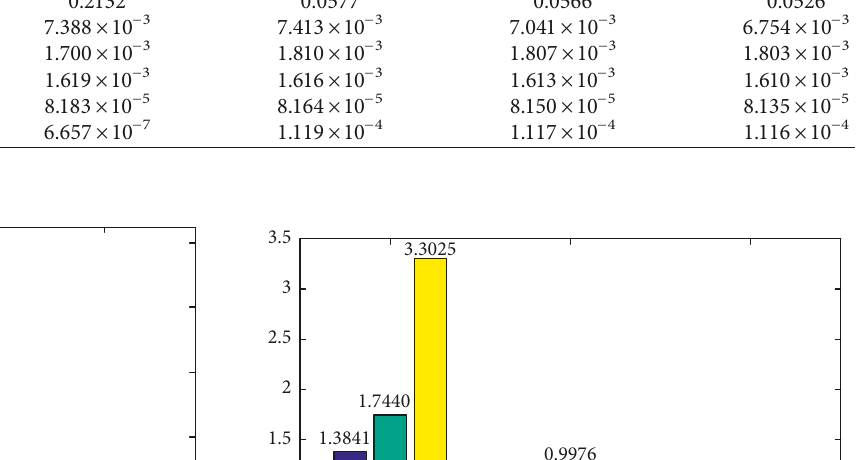
Table 5: The amount of change of RI , Ne , Fe 1, Fe 2, Fe 3, and Fe 4 under different rub-impact clearances ( μ m).